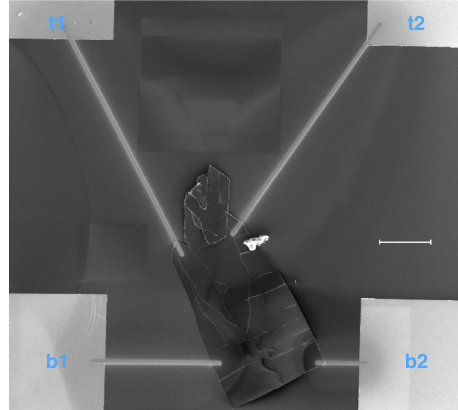
Fig. 6 SEM image of the device used in all electrical and photoelectrical characterisations. It consists of a p -Si/SiO 2 wafer onto which a MOF- CoNDI-py-2 single crystal is connected to Au pads, labelled t1 , b1 , t2 and b2 , by deposited Pt electrodes. Scale bar = 100 μ m